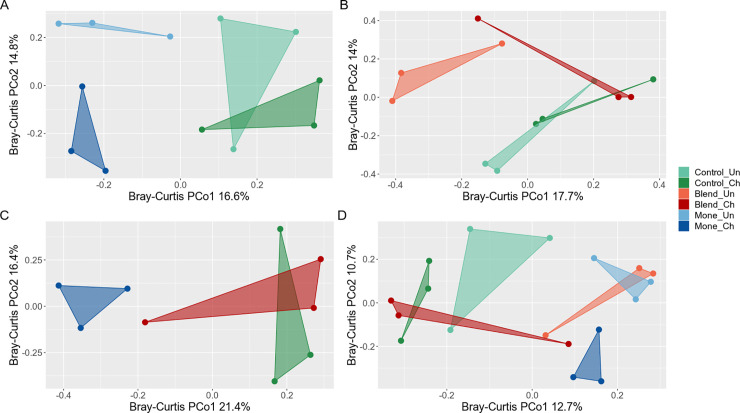
Principal coordinate analysis (PCoA) of beta diversity based on Bray-Curtis dissimilarity in a broiler experiment composed of three feeding additives, basal diet (control), sodium monensin (Mone), or blend (Blend) and coccidiosis challenge (CH) or unchallenged (UN).(A) Comparison between Mone and control treatments (Adonis with 999 permutations, p = 0.002). (B) Comparison between blend and bcontrol treatments (Adonis with 999 permutations, p = 0.252). (C) Comparison between Mone, blend, and control treatments challenged with coccidiosis (Adonis with 999 permutations, p = 0.179). (D) Between all treatments (Adonis with 999 permutations, p = 0.002).